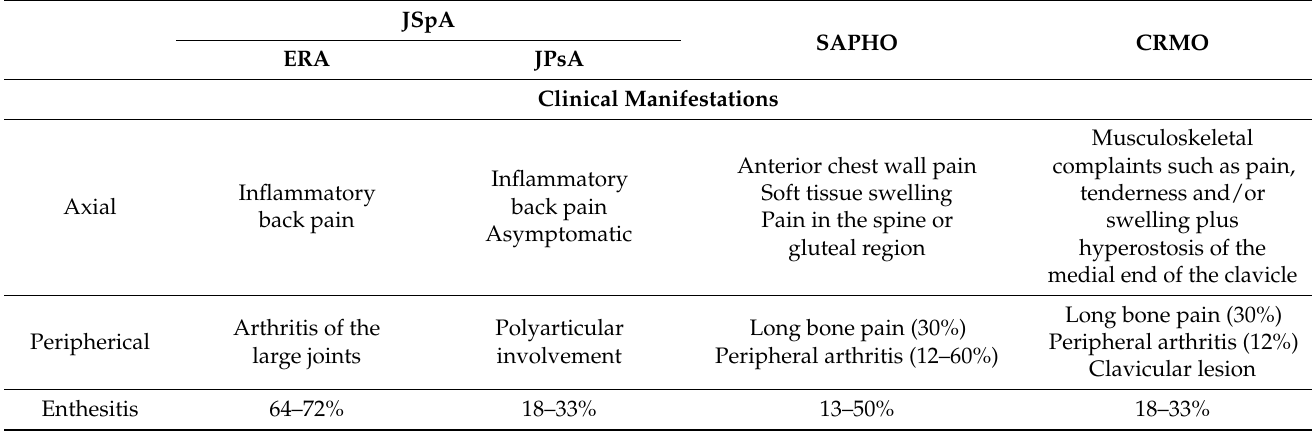
Table 2. Comparative table of clinico-radiological characteristics of JSpA, CRMO and SAPHO